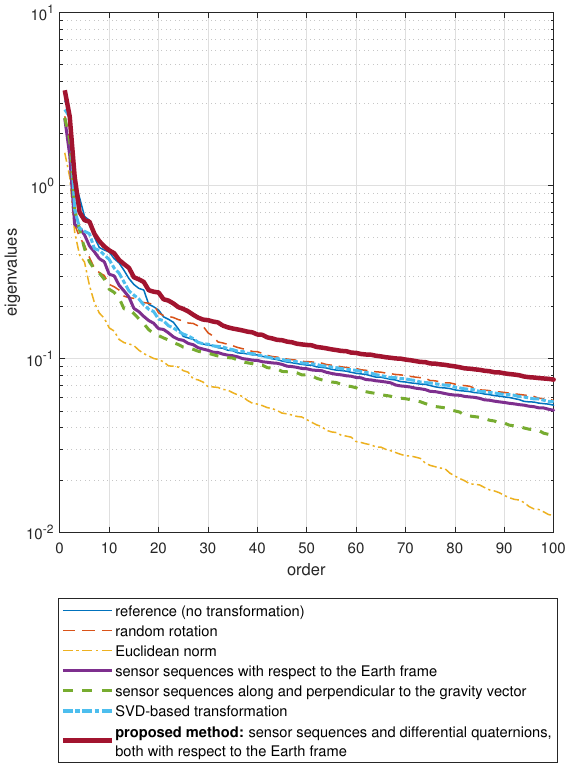
Figure 8. The first 100 eigenvalues of the covariance matrix of the feature vectors sorted in descending order, calculated based on the features extracted from the data transformed according to the seven